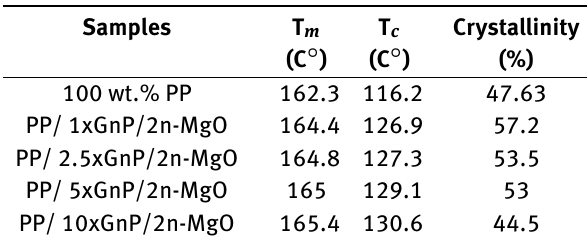
Table 3: Thermal properties of PP and corresponding nanocompos-